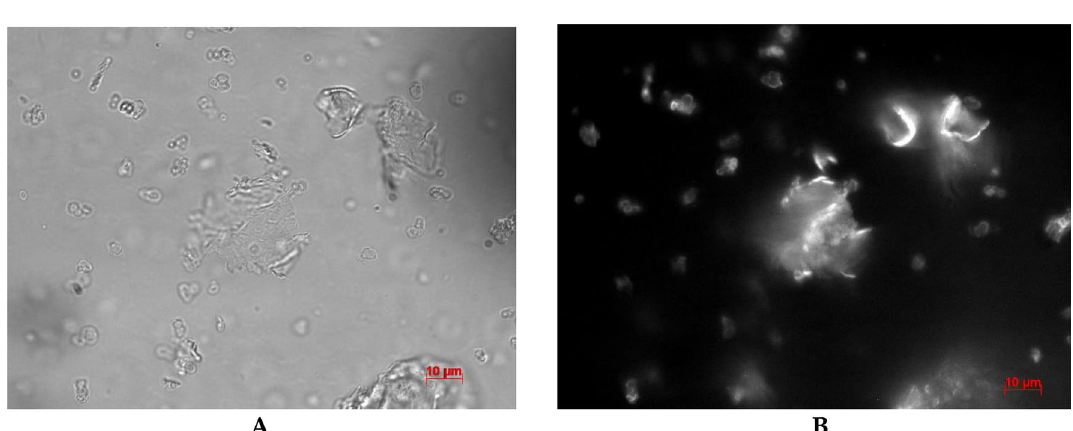
Figure 2. Image of polyelectrolyte microcapsules in 3000 μg/ml SDS solution after 180 min of incubation ( A ) light microscopy, ( B ) fluorescence